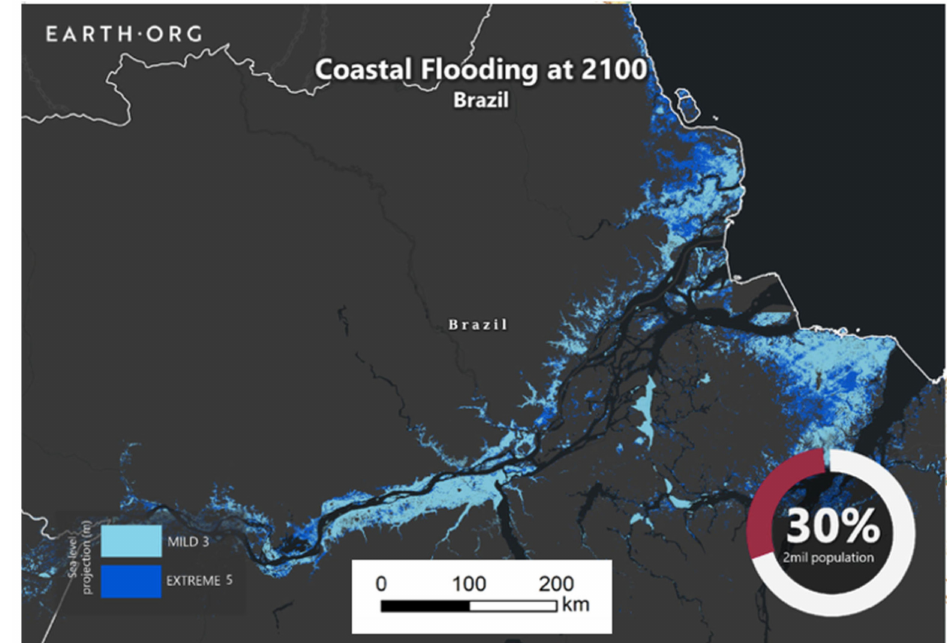
Figure 4. Sea-level rise projections by 2100 for two scenarios with mild (3 m) and extreme (5 m) rises. Downloaded on 16 March 2021 from Earth Org (https://earth.org/data_visualization/ sea-level-rise-by-2100-amazon-river-delta/2021, accessed on 15 February 2021 ). Map based on sea-level rise scenarios forecast by Climate Central—Coastal Risk Screening Tool (https://coastal. climatecentral.org/map/3/85.7984/25.273/?theme=sea_level_rise&map_type=year&basemap= roadmap&contiguous=true&elevation_model=best_available&forecast_year=2050&pathway=rcp4 5&percentile=p50&refresh=true&return_level=return_level_1&slr_model=kopp_2014, accessed on 15 February